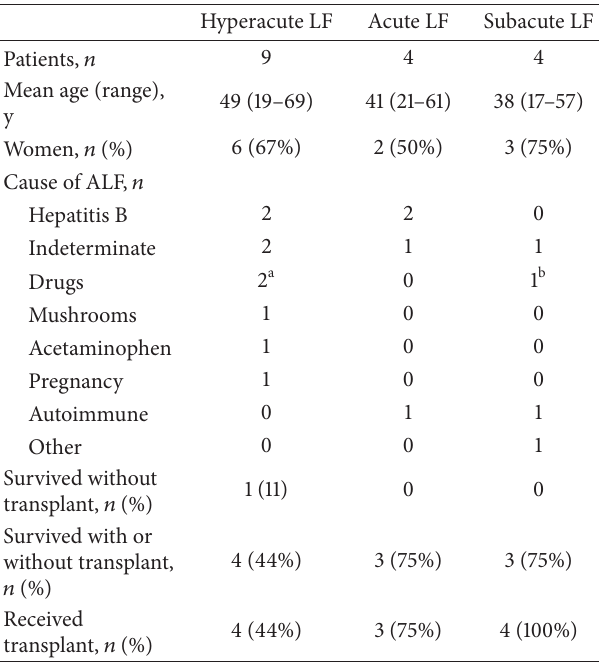
Table 1: Clinical characteristics of patients according to O’Grady